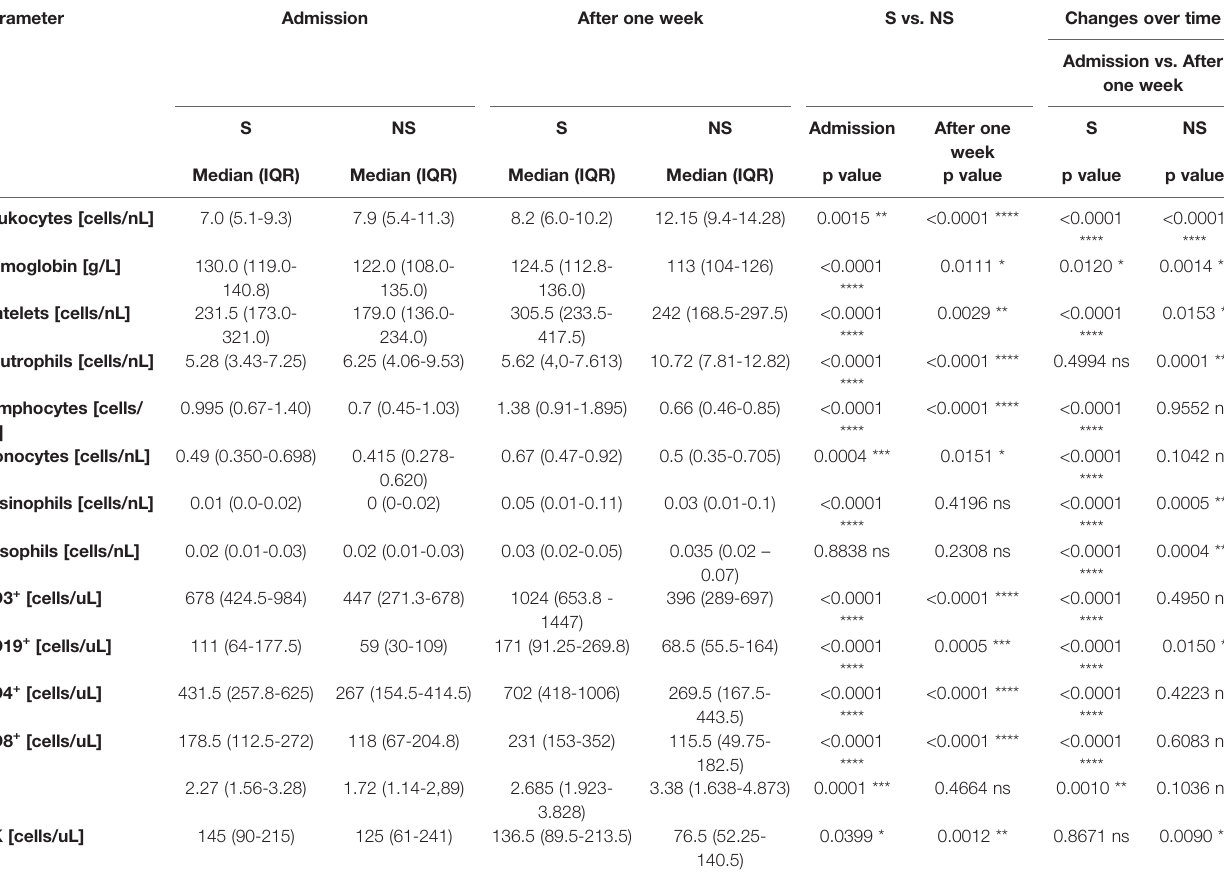
TABLE 3 | Results of differential blood cell counts and basic lymphocyte subsets in survivors (groups A – C) and non-survivors (group D) on admission to the hospital and after one week of hospitalization.